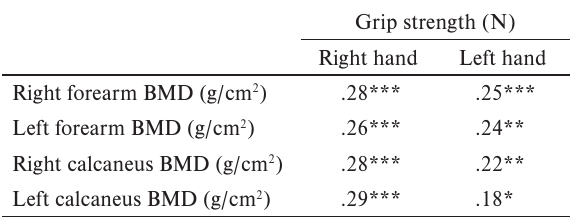
Table 5 The relationship between muscle strength in the hand flexors and bone mineral density using Pearson correla- tion